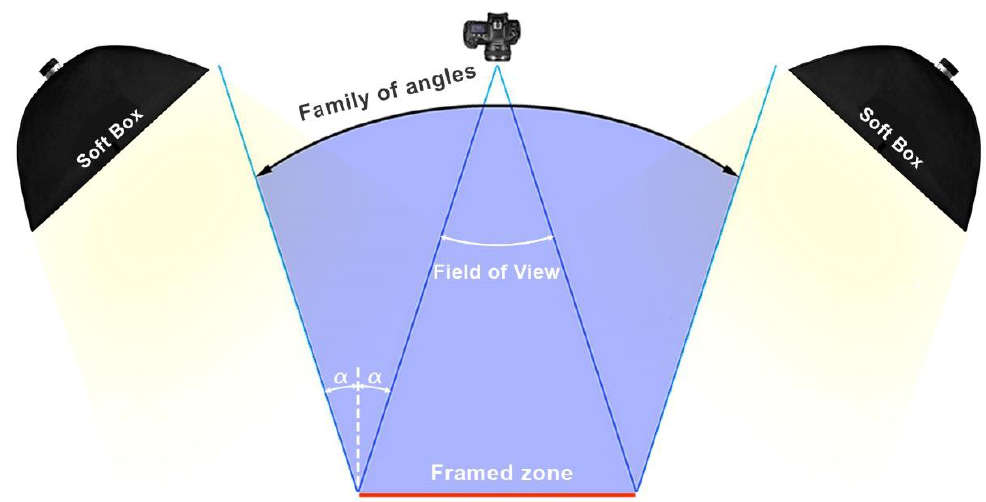
Figure 9. Lighting scheme to illuminate the artwork uniformly. In order to avoid specular reflections on the canvas, the light sources must be placed outside of the volume defined by the family of angles.